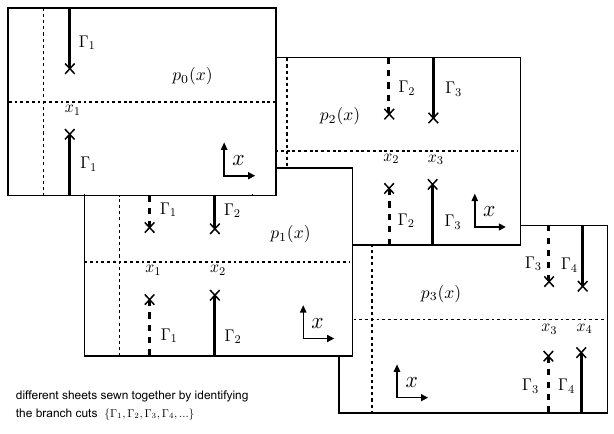
Figure 4 . After the re-summation of probe corrections, the leading order forbidden thermal poles are \resolved" into a series of branch-cuts. Through them a chain of additional saddles p n ( x ) are sewn together, and form an in(cid:12)nite Riemann surface M p